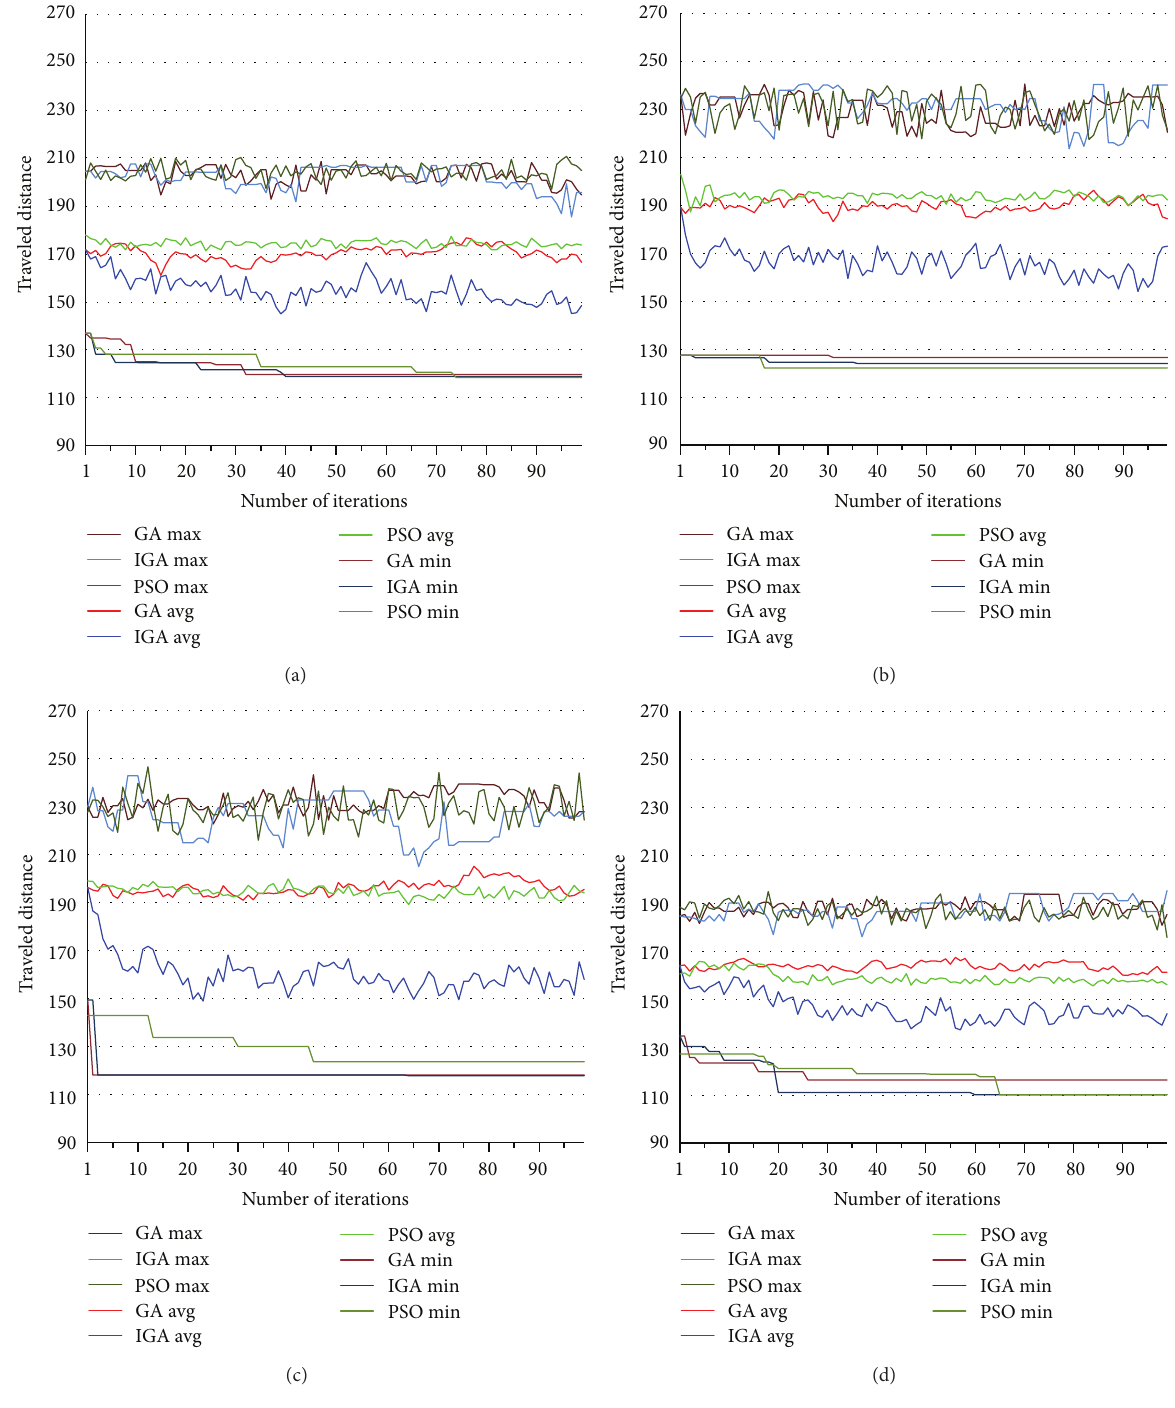
Figure 9: The shortest traveled distance for simulation results for Case 3. 10 goods overlap by GA, IGA, and PSO. (a) Goods type A, (b) goods type B, (c) goods type C, and (d) goods type